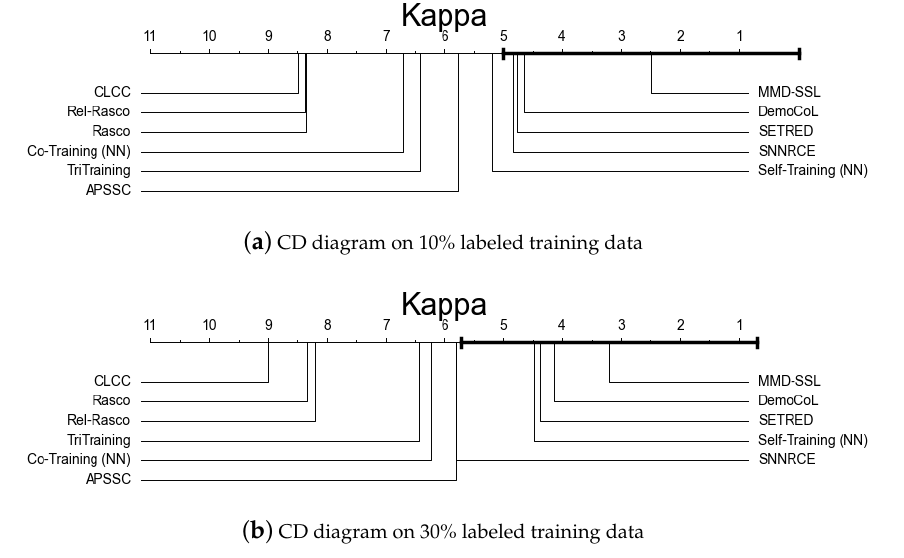
Figure 5. Critical difference diagrams corresponding to kappa comparisons in Tables 5 and